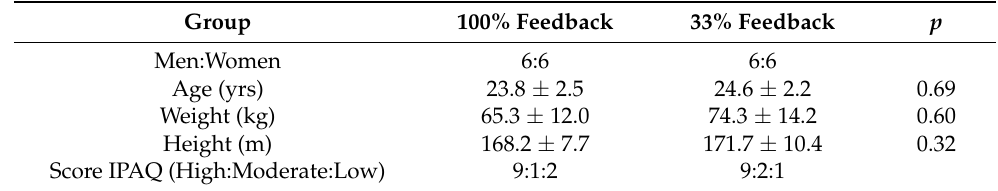
Table 1. Mean ± standard deviation of the morphological and demographic characteristics and reported physical activity of the participants of each group.